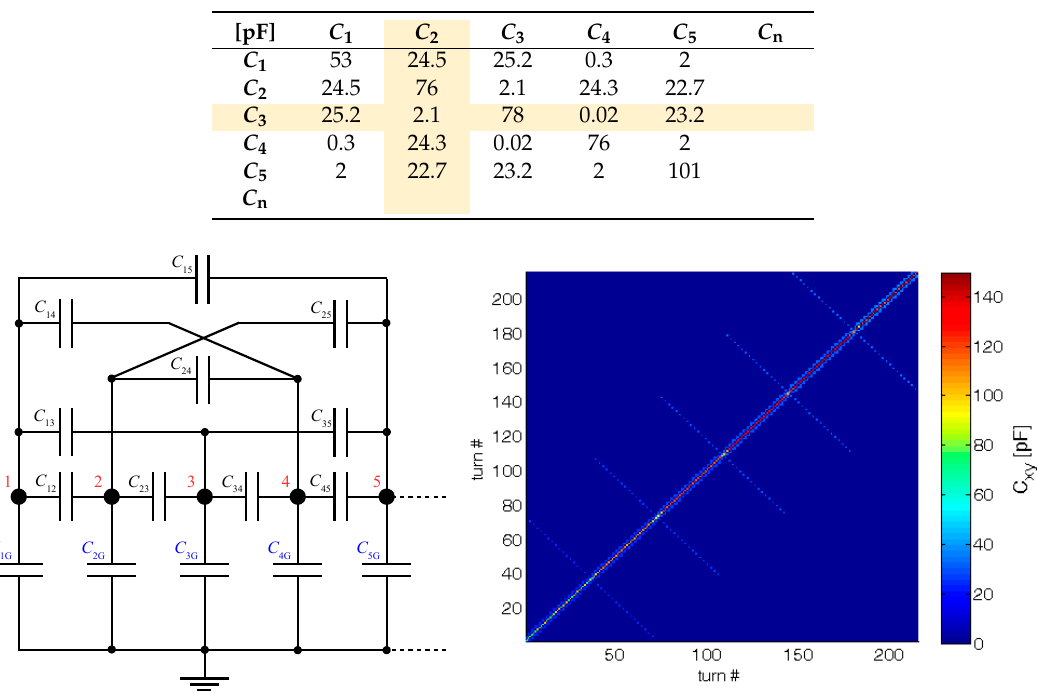
Figure 10. Axisymmetric FE model ( left ); calculated voltage distribution ( right ) across the model. Table 3. Stray capacitance matrix calculated for transposed winding (Figure 9—left, blue).